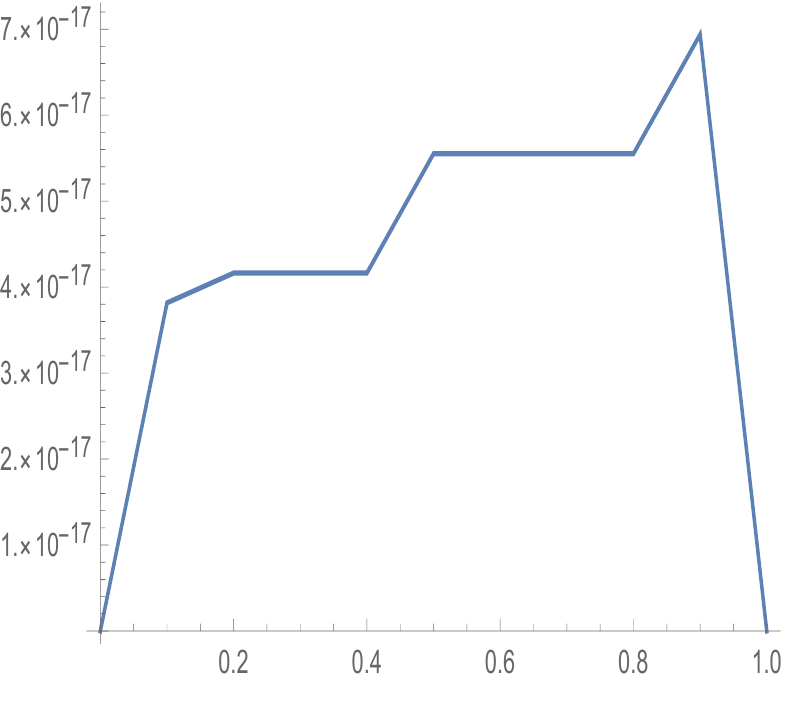
Figure 3. Plot of the ABER with PHNT for h = 1